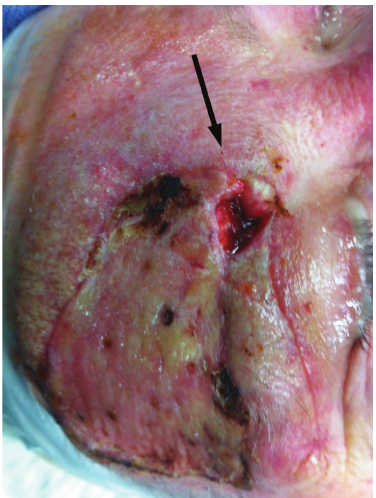
F 2: Wound dehiscence at the primary site